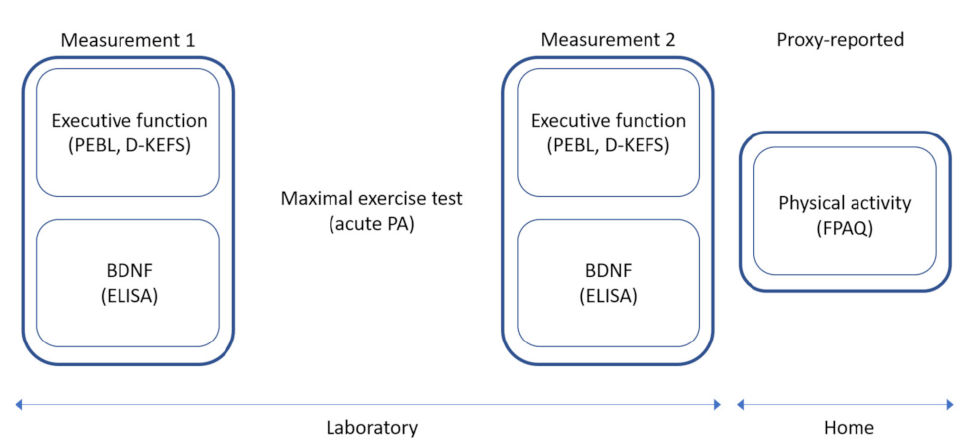
Figure 1. Overview of the different measurements that were conducted (FPAQ = Flemish Physical Activity Questionnaire; BDNF = Brain-Derived Neurotrophic Factor; PEBL = the Psychology Experi- ment Building Language test battery; D-KEFS = Delis-Kaplan Executive Function System test battery; ELISA = Enzyme-Linked Immunosorbent